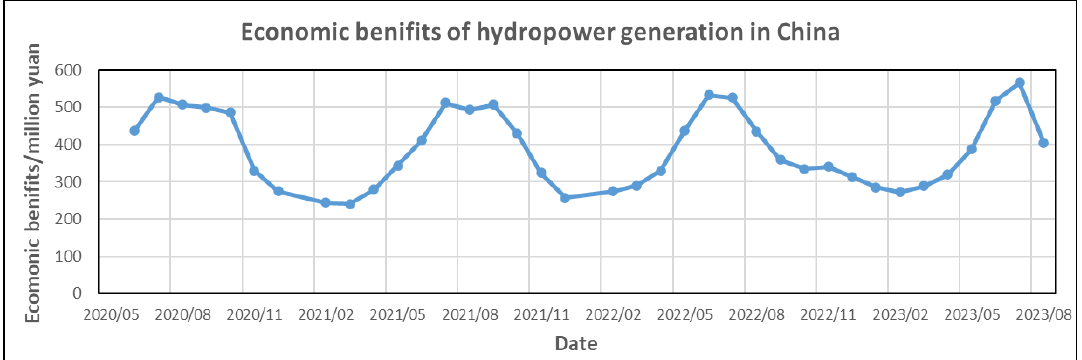
Figure 7. Predicted values of economic benefits of hydropower generation in China.